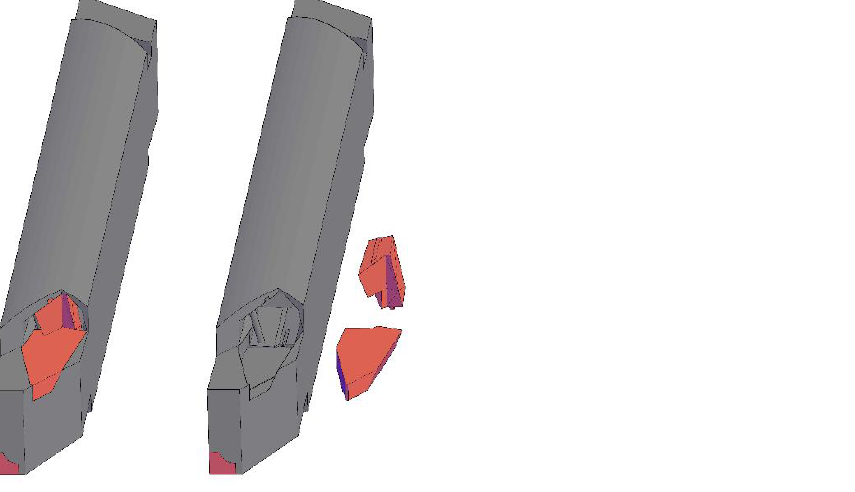
Figure 17. A 3D model beam (H2) drawing of the structural repair of the damaged beam.